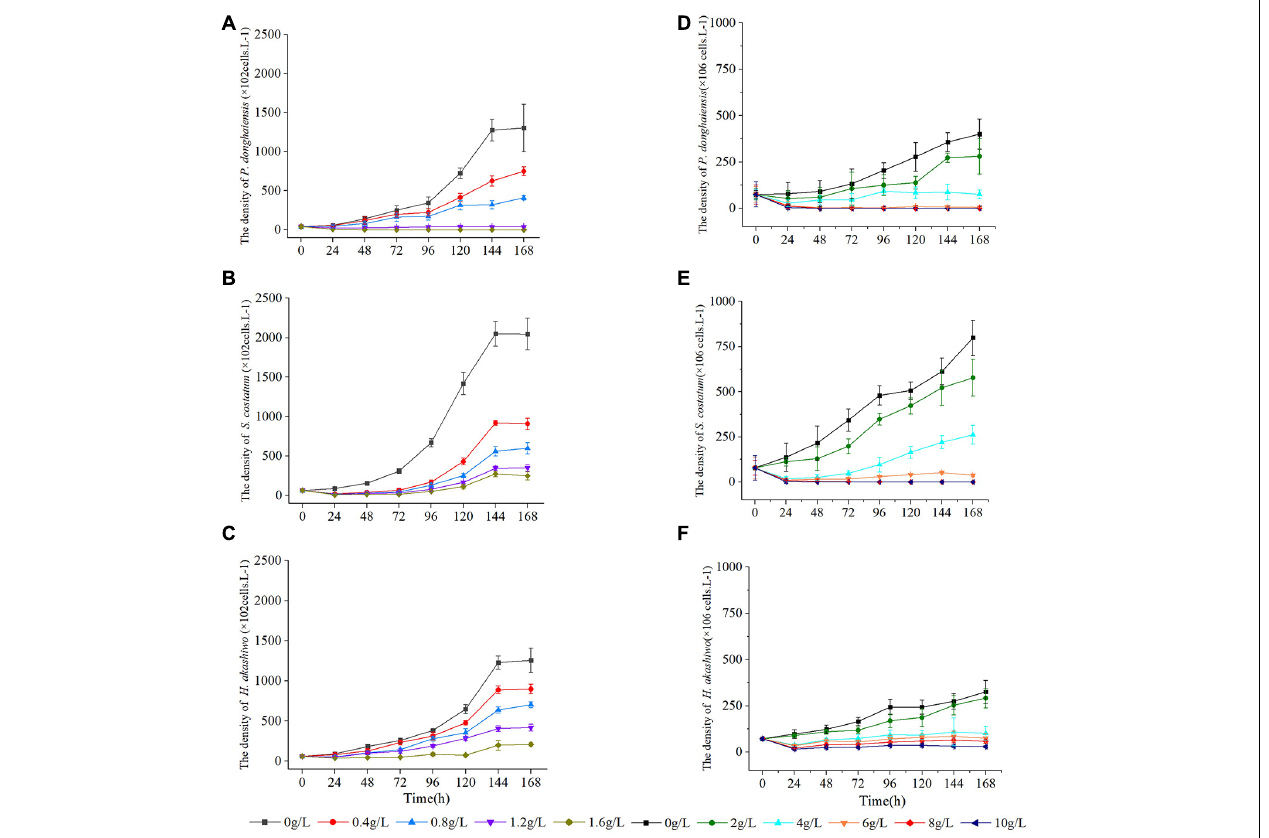
FIGURE 4 | Effect of hijiki extracts on, Prorocentrum donghaiensis, Skeletonema costatum , and Heterosigma akashiw Low density (A–C) and high density (D–F) .